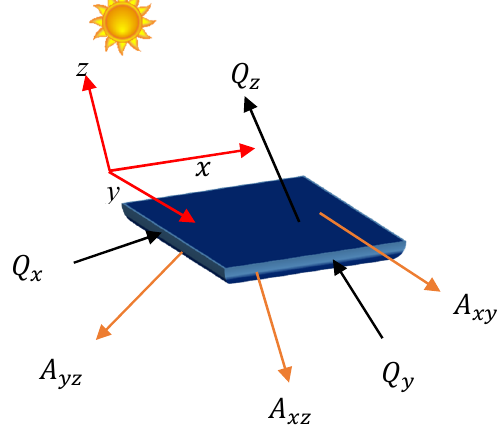
Figure 3. The conduction heat transfer directions in a solar cell.